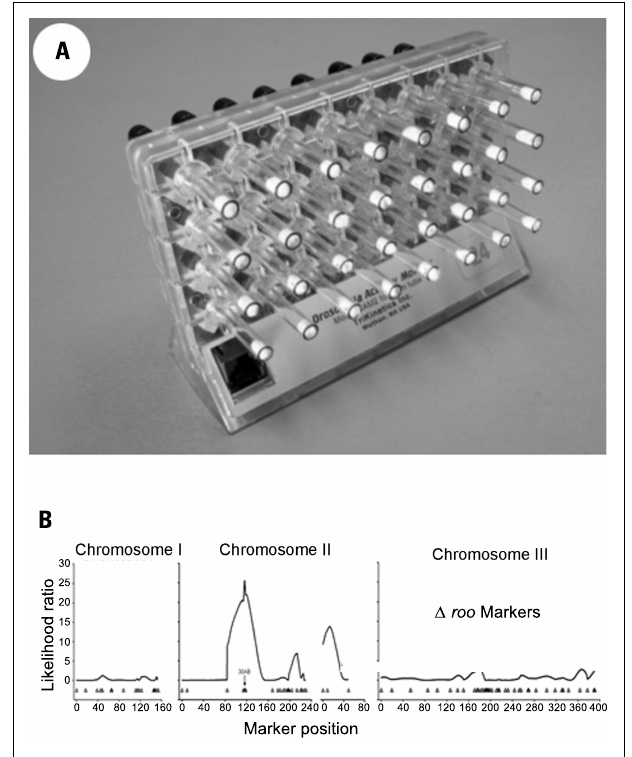
FIGURE 1 | (A) Drosophila Activity Monitor with glass tubes containing one adult fly, food at the far end and a cotton plug visible on the other end of each tube. (B) A behavioral QTL at region 30AB of Drosophila melanogaster chromosome two, for changes in activity level induced by developmental exposure to